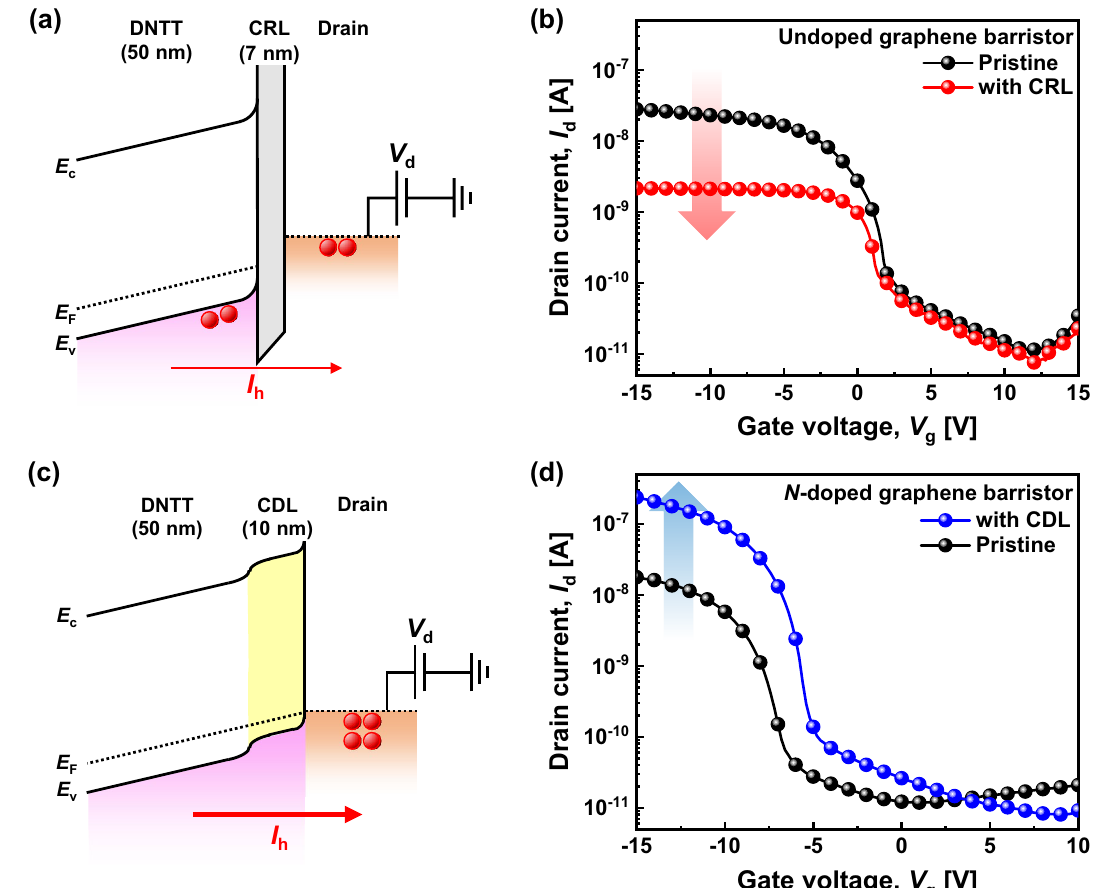
Figure 3. ( a ) Schematic band diagram with CRL. ( b ) Transfer curves of undoped graphene barristors with and without CRL at V d = − 2 V. ( c ) Schematic band diagram with CDL. ( d ) Transfer curves of n -doped graphene barristors with and without CDL at V d = − 2